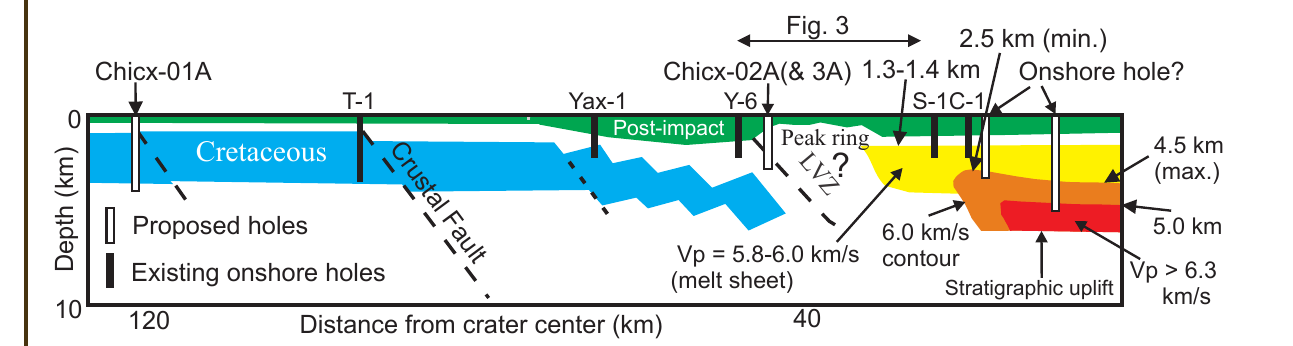
Figure 2. Proposed structure of Chicxulub Crater from geophysical data and drilling (Morgan et al., 2005). The Cretaceous, post-impact sediments, peak ring, and top of the melt sheet are all imaged on marine seismic reflection data. The shape of the melt sheet (yellow) and central uplift (red and orange) are inferred from tomographic seismic velocity data. There is a low velocity zone (LVZ) of unknown origin beneath the peak ring. Chicx-01A is a hole through intact target rocks just outside the crater, and Chicx-02A and 03 are holes through the crater’s topographic peak